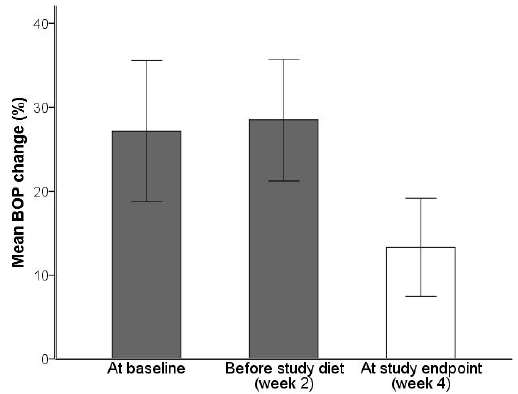
Figure 3. Bar chart diagram illustrating mean changes in bleeding on probing (BOP; %) at different time points of the study (baseline [mean ± S.D.; 27.1 ± 10.0], before study diet [28.5 ± 8.7] and at study endpoint [13.3 ± 7.0]).